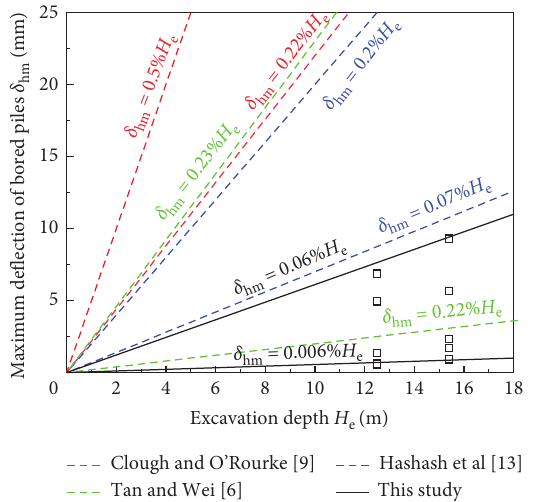
Figure 13: Relationship between the maximum deflections of bored piles and the excavation depths.